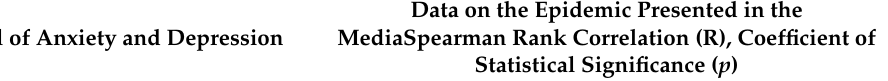
Table 6. Selected data on the epidemic presented in the media and the level of anxiety and depression: univariate analysis (Spearman’s rank